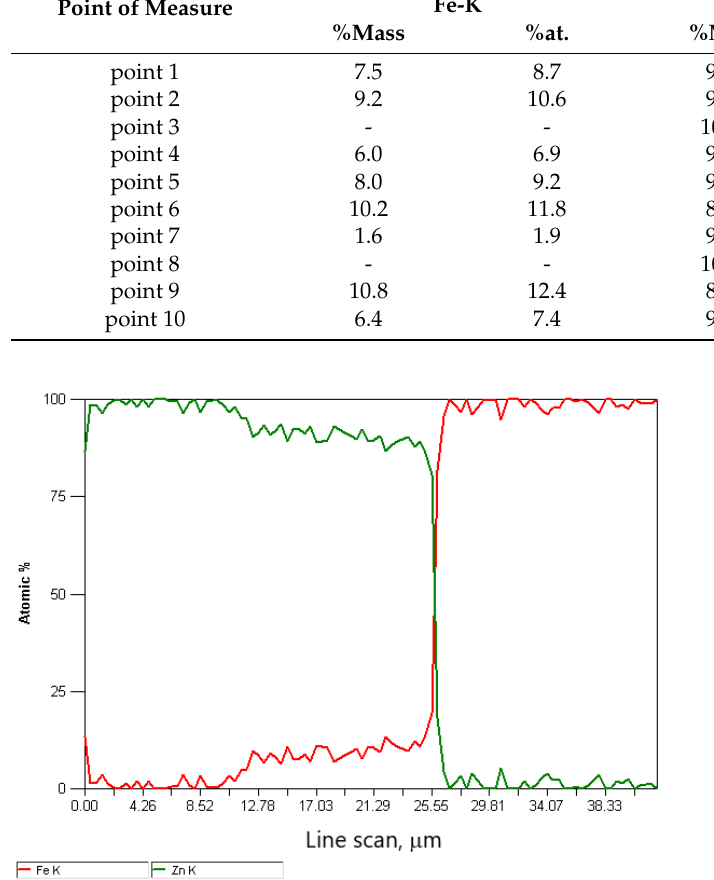
Figure 6. The EDS X-ray spectral analysis in the coating micro-areas on the cross-section of the galvanized H20 variant wire.